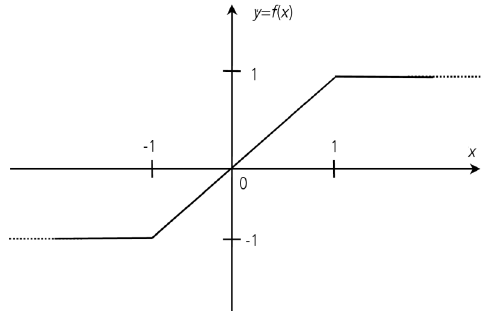
Fig. 3. Piece-wice linear output function of